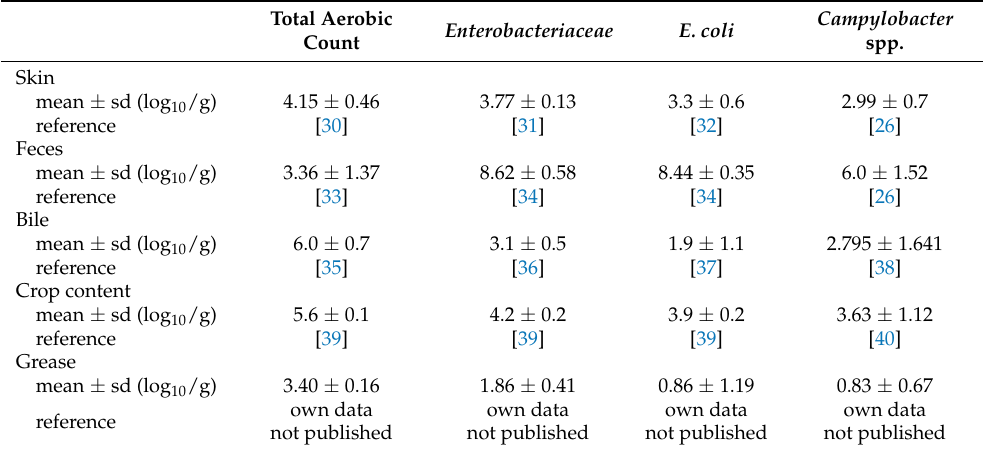
Table 2. Number of bacteria per gram in different types of contaminations expressed in log 10 .